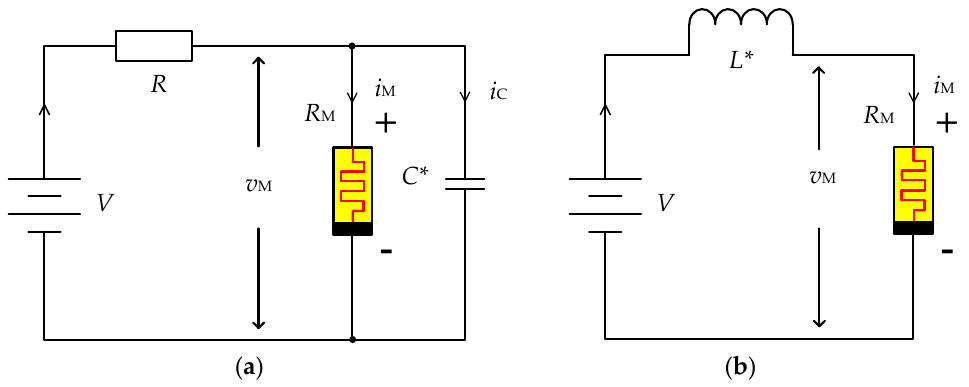
Figure 8. ( a ) Parallel capacitance and ( b ) series resistance of locally active memristor oscillation circuit.